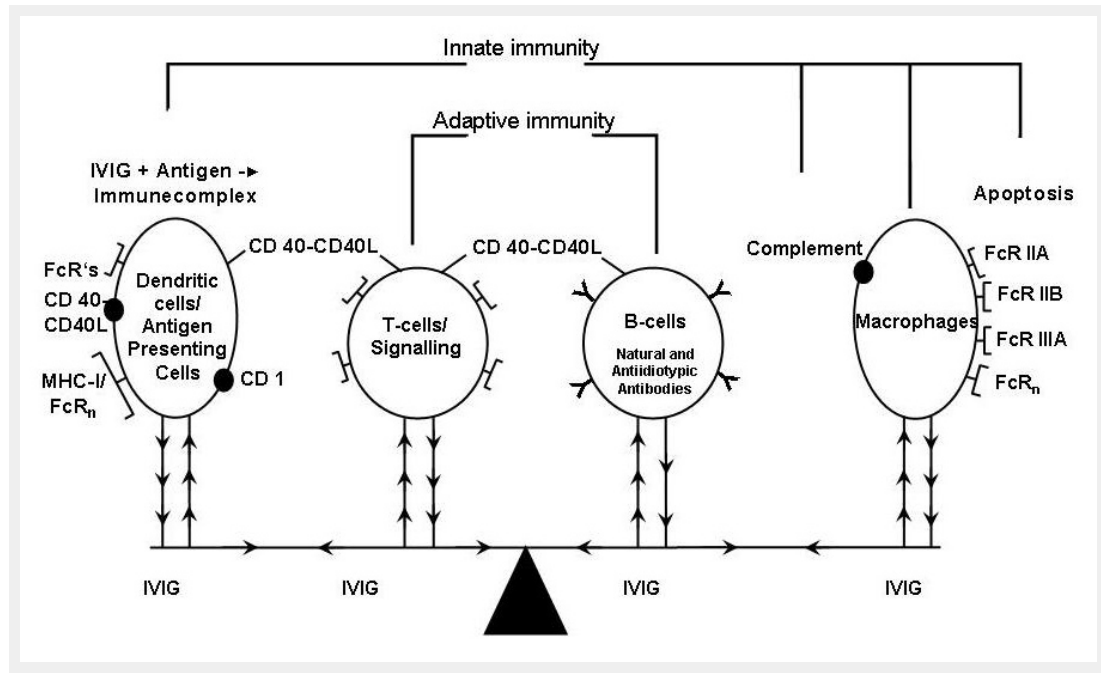
Figure 3 Synergistic (arrows) interactions after IVIG administration. From left to right hand side: – Immune complex formation, activation of dendritic cells and their Fc receptors; – Antiplatelet T-cell reactivity, suppression of T cells, cytokine release and increase of T regulatory cells; – Downregulation of B-cells and anti-idiotypic antibodies; – Blockade of Fc receptors by IVIG; Complement binding/clearing Apoptosis and Fas inhibition (modified from © Imbach P, Lazarus A, Kühne T. Intravenous immunoglobulins induce potentially synergistic immunomodulations in autoimmune disorders. Vox Sanguinis. 2010;98:385–94. Reprinted with kind permission).